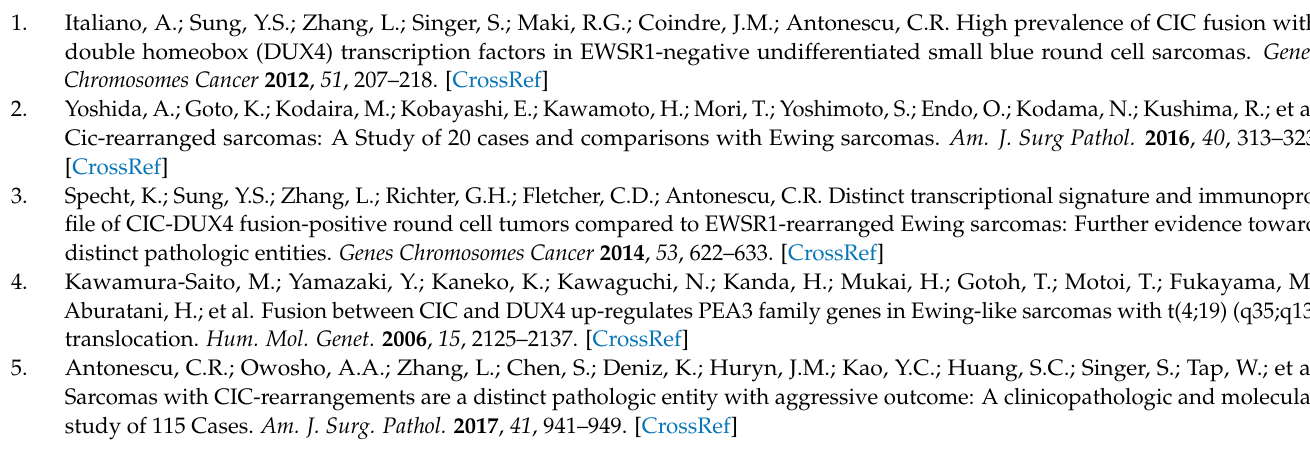
Table S2: Primers used for the detection of the CIC-DUX4 gene. Supplementary Figure S1: CAM tumor derived from CIC-DUX4 sarcoma cells was stained for the presence of fibroblast using C1 antibody as described in Materials and Methods. Negative control shows staining without the antibody. A scale bar represents 0.05